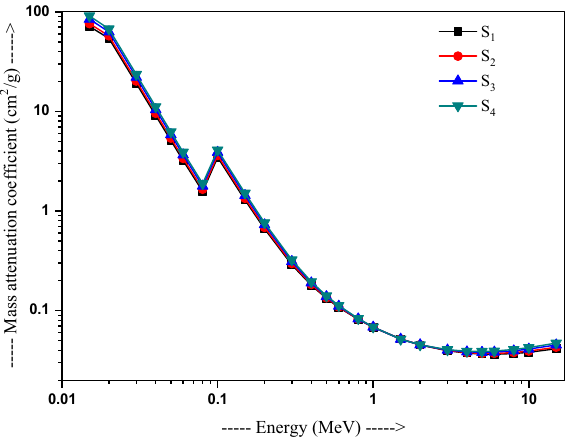
Figure 2. Variation of mass attenuation coefficient with energy in 20Bi 2 O 3 − xPbO − (80 − 2x)B 2 O 3 − xGeO 2 (x = 5, 10, 20, and 30 mol%) glasses.